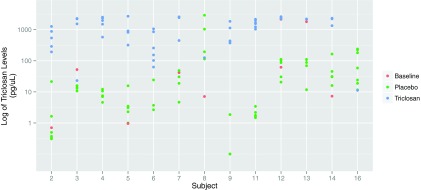
Triclosan levels in the subjects. Urine samples were tested in triplicate for levels of both triclosan and glucuronidated triclosan, and 97% of the samples were used in the analysis (one sample was excluded due to technical problems, and three were excluded due to date of collection [those samples were taken 1 day after switching between arms]). Seventy-one subsamples far exceeded the upper limit of quantification (>70 pmol/µl), and 84 subsamples were below 10 fmol/µl; 47 (35%) samples were affected by this rounding.